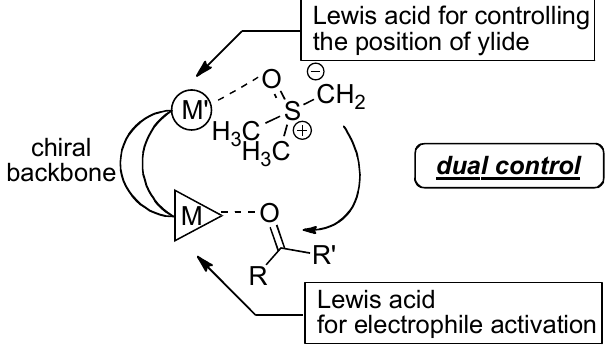
Figure 2. Working hypothesis to realize high enantio induction with doubly Lewis acidic chiral bimetallic/multimetallic